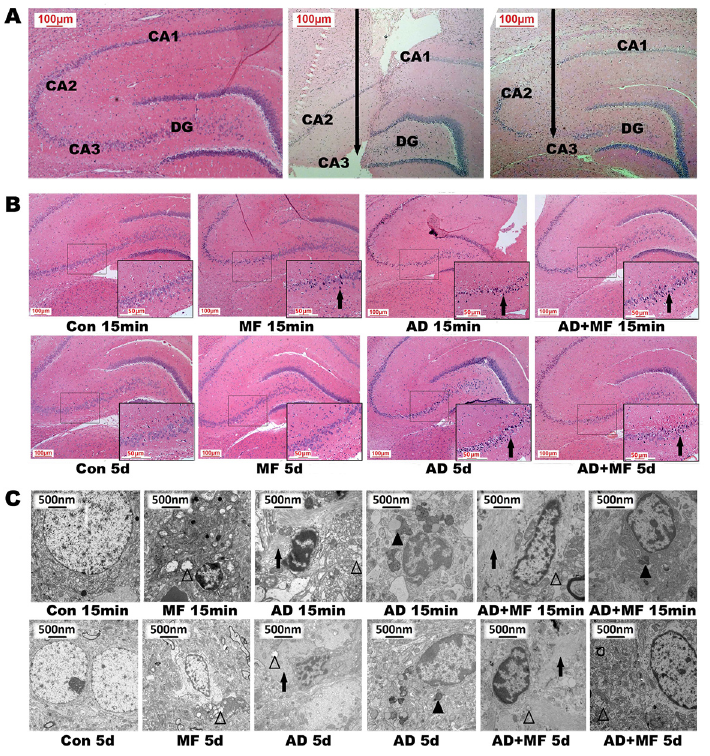
Fig 2. The hippocampal injection site and pathologic change in the CA3 region after exposure to 50 Hz and 400 μ T of ELF-EMF for 60 days. (A-a): Hippocampal formation. (A-b, c): 1d and 7d after hippocampal injection, HE staining, ! : injection site. (B) HE staining. CA3 region was enlarge in the right bottom box. ! : nuclear contraction. (C) Electron microscope observation. ! : neurofibrillary tangle; ▲ : lipofuscin deposition; Δ : well and focal cavitations of